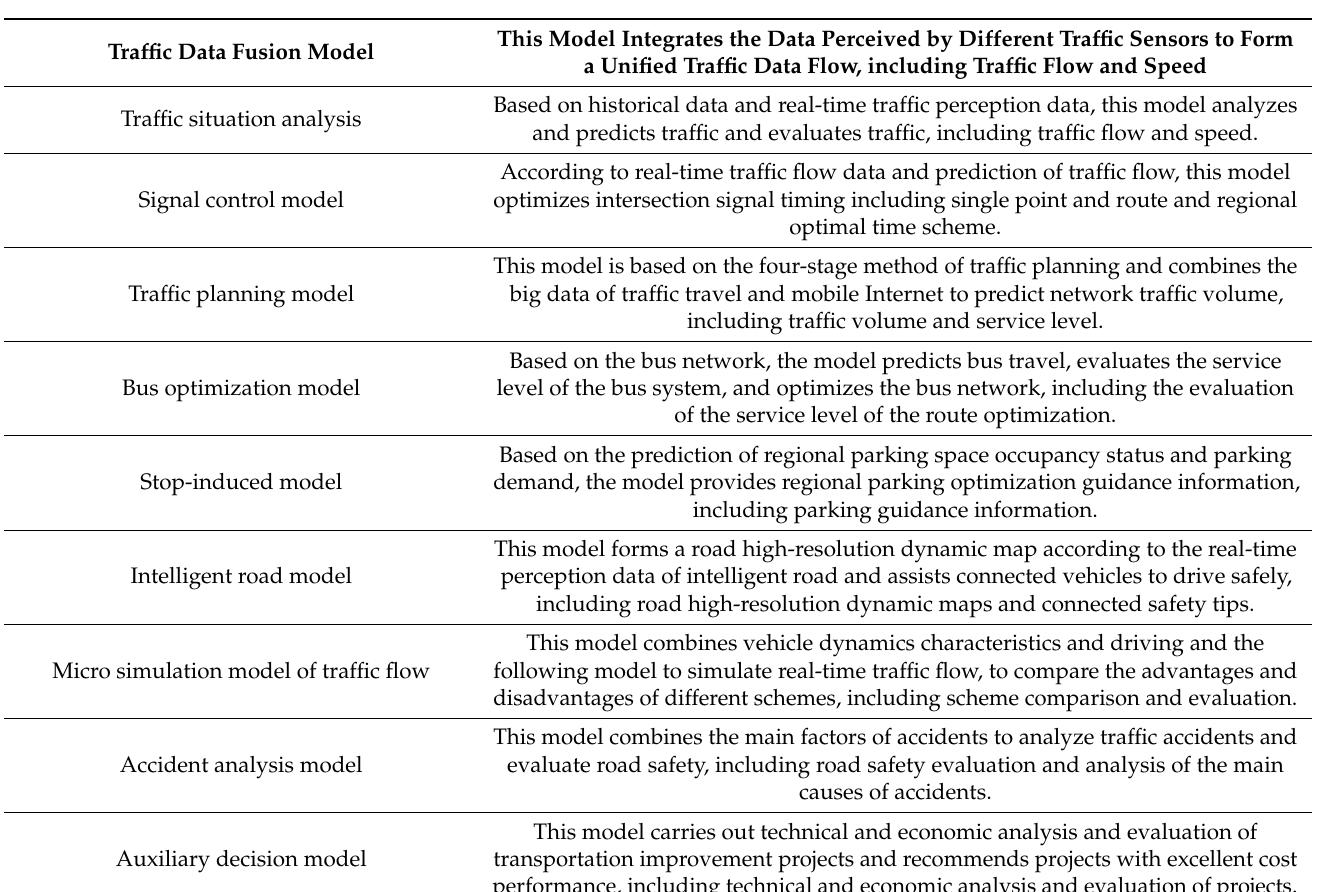
Table 1. Possible traffic model of DTs